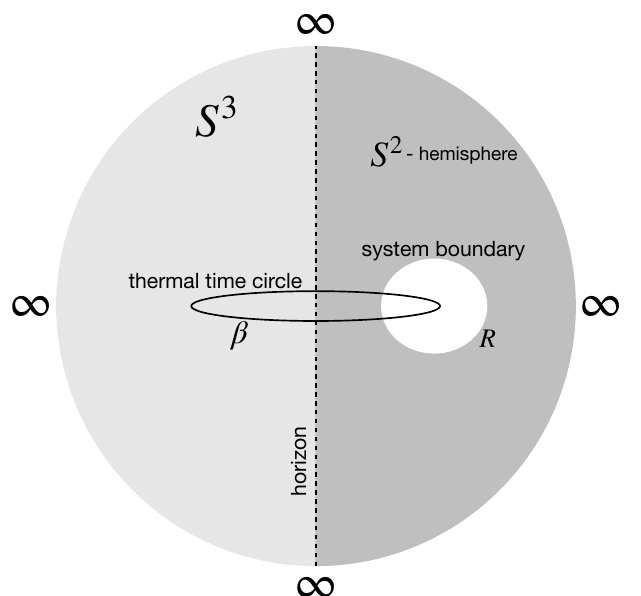
Figure 13. A geometry in the Euclidean path integral for the partition function in three spacetime dimensions. The topology is S 3 , represented as a 3-ball with all of its surface points identified (and labeled as “ ∞ ”). (See text for